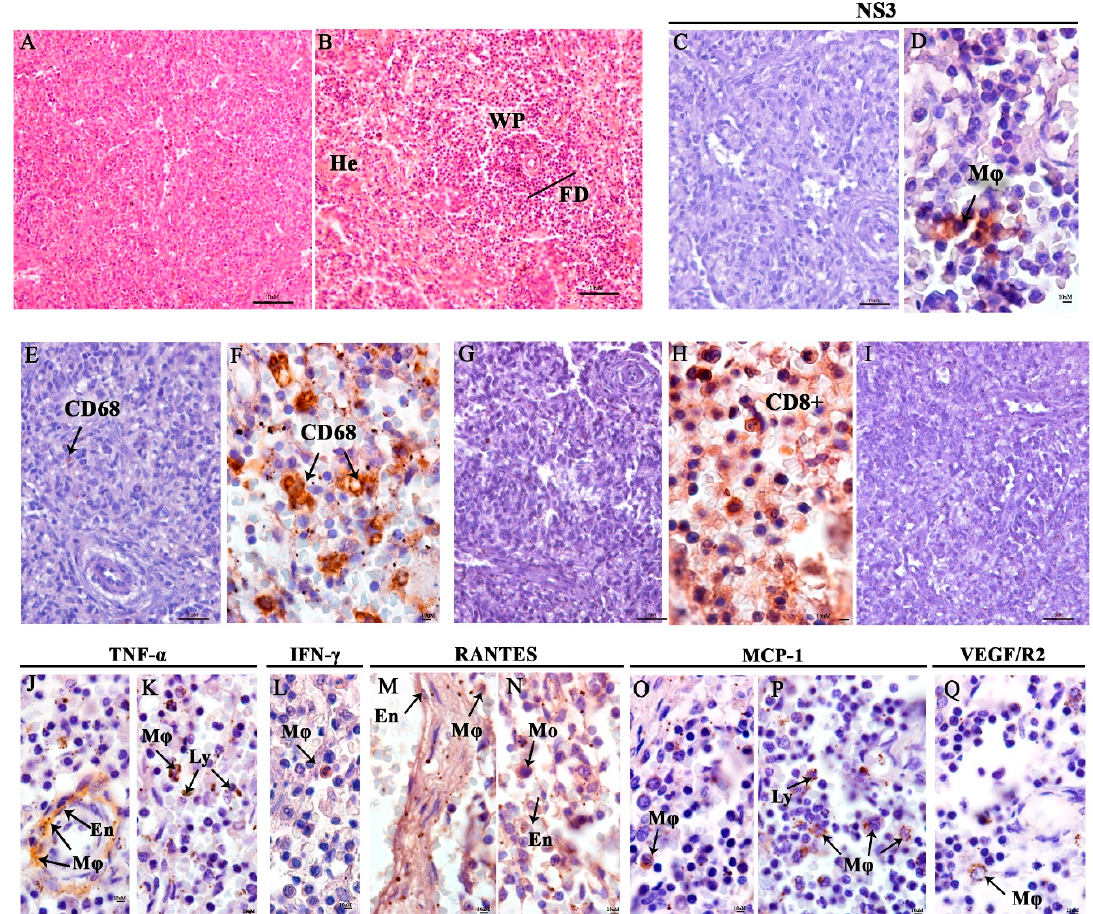
Figure 5. Histopathological and immunohistochemistry analysis of the spleen. ( A ) Spleen of a non-dengue case. ( B ) In the stillborn spleen, hemorrhage (He) in the red and white pulps, and follicle disorganization (FD) in the white pulp, were observed. ( C ) Negative control without NS3 staining. ( D ) Detection of DENV NS3 protein in macrophage (Mø). ( E , F ) Presence of CD68. Negative control without TCD8 + cells ( G ). ( H ) Presence of T CD8 + cells in red pulp. ( I ) Representative negative control of cytokine and inflammatory mediators from a non-DENV case. ( J , K ) TNF- α in macrophages (Mø), endothelial cells (En), and lymphocytes (Ly), ( L ) IFN-y in macrophages, ( M , N ) RANTES in macrophages (Mø), endothelial cells (En) and monocytes (Mo), ( O , P ) MCP-1 in macrophages (Mø), lymphocytes (Ly), and ( Q ) VEGF/R2 only in macrophages (Mø).